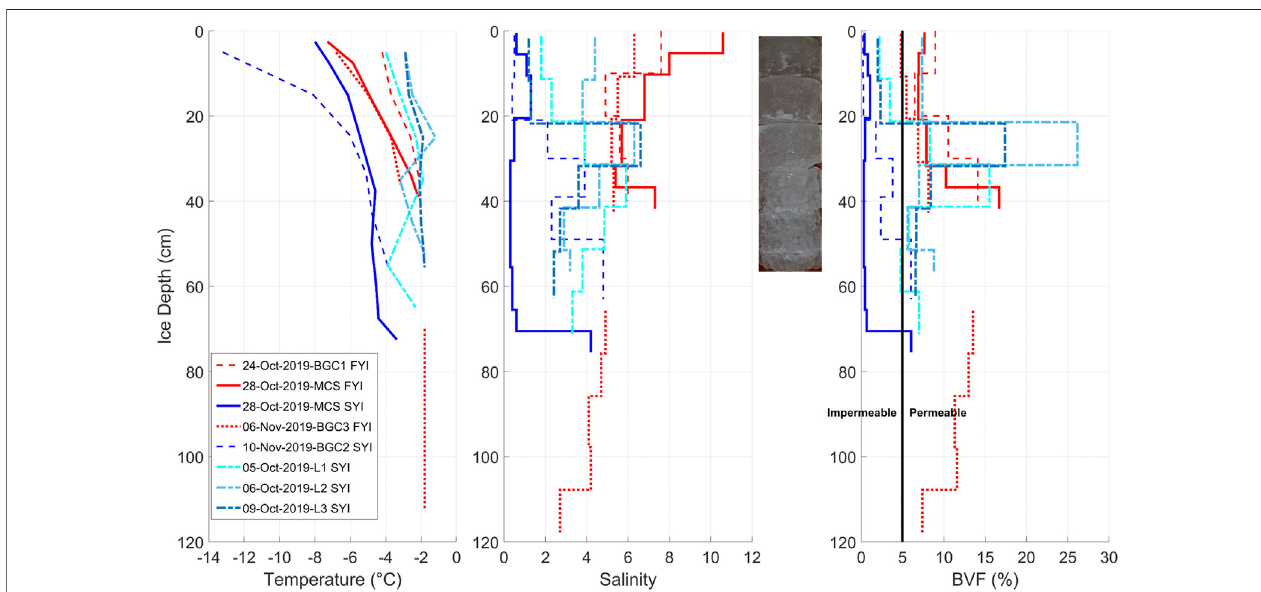
FIGURE 2 | The initial ( fi rst site visit) temperature, salinity, and brine volume fraction ( BVF ) pro fi les taken from ice cores used for methane concentration analysis at the BGC sites, the main coring sites (MCS), and the Distributed Network. For the rafted FYI (BGC3), the ice mass below the seawater pocket was assumed to be isothermal because no temperature measurements were taken. The salinity pro fi les highlight the spatial variability of physical properties between FYI and SYI, as well as the variation withinSYI. Toshow how the porous ice in thebottom segment ofthe ice inearly autumn relate tothe salinity pro fi le, an ice corephotograph from L2 is shown. The salinity for the 40 – 50 cm segment of L1 was linearly interpolated because of a leaking sample bag. The salinity and BVF pro fi les between each core are slightly offset vertically to ease